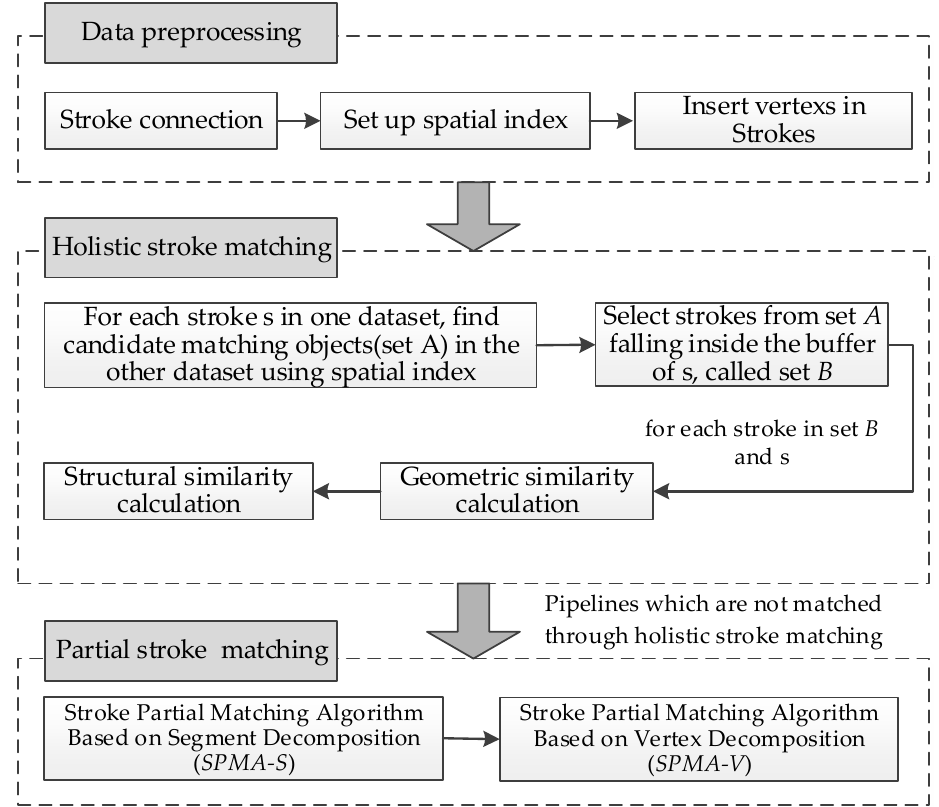
Figure 13. The steps of matching underground pipeline networks.